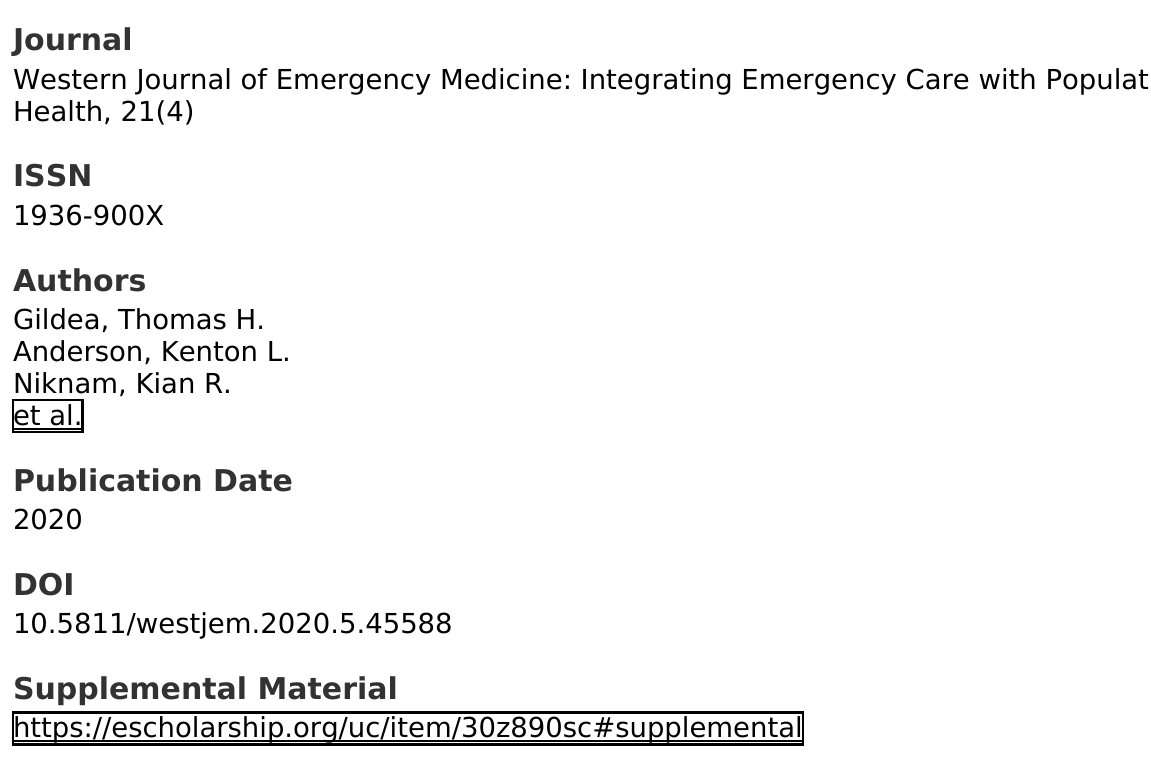
The Utility of Color Doppler to Confirm Endotracheal Tube Placement: A Pilot